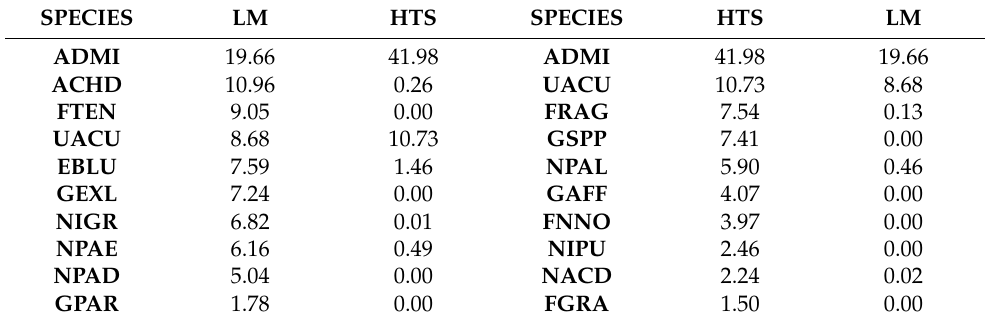
Table 2. Comparison of relative abundances of dominant diatom taxa assesses by LM and HTS methods in the studied ponds. Diatom species are codified by OMNIDIA codes: Achananthidium minutissimum (ADMI), Achnanthidium sp. (ACHD), Fragilaria tenera (FTEN), Ulnaria acus (UACU), Eunotia bilunaris (EBLU), Gomphonema exilissimum (GEXL), Nitzschia gracilis (NIGR), Nitzschia paleacea (NPAE), Nitzschia paleacea var. debilis (NPAD), Gomphonema parvulum (GPAR), Fragi-